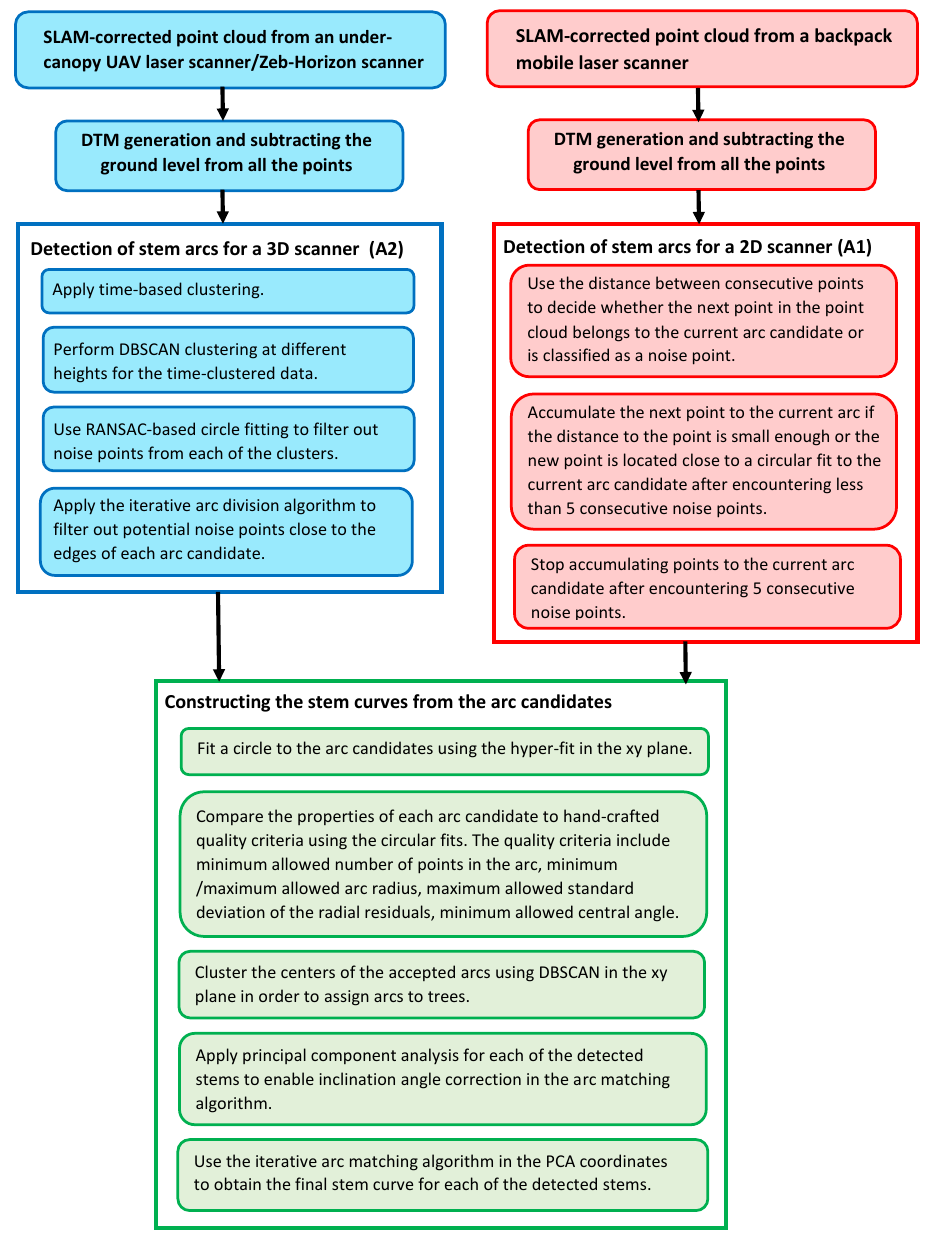
Figure 6. Flow chart of the stem curve extraction algorithm used for the backpack laser scanner, under-canopy UAV laser scanner, and handheld laser scanner. The algorithms are based on our previous work